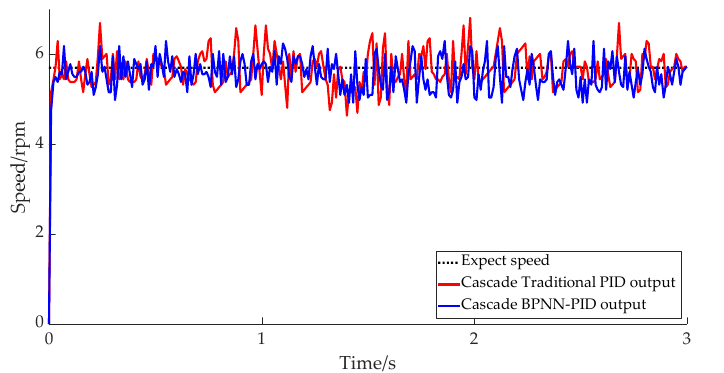
Figure 12. Tool rest lifting mechanism actual speed outputs.